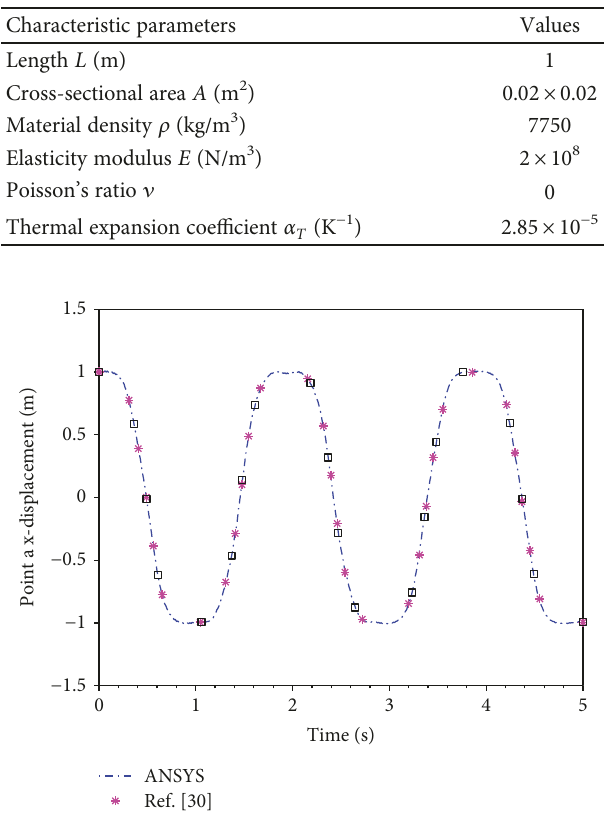
Figure 3: The displacement of point a.